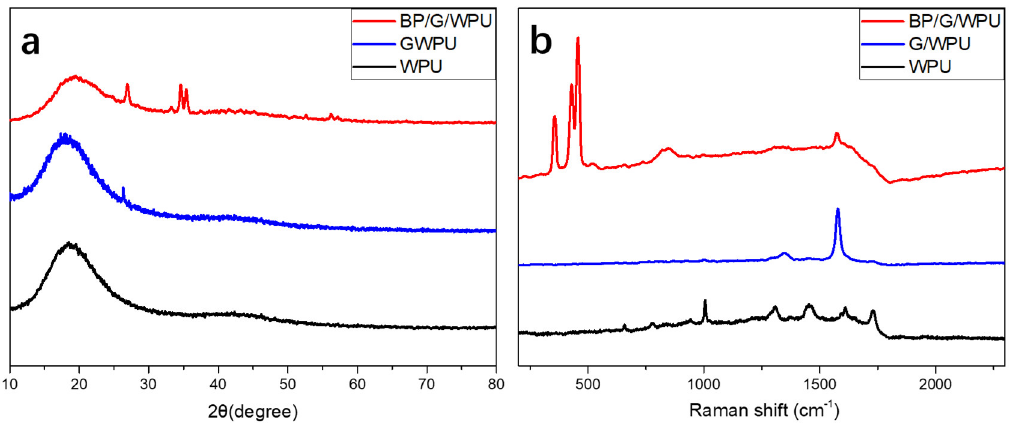
Figure 5. ( a ) XRD spectra of WPU, G/WPU and BP/G/WPU; and ( b ) Raman spectra of WPU, G/WPU, and BP/G/WPU.